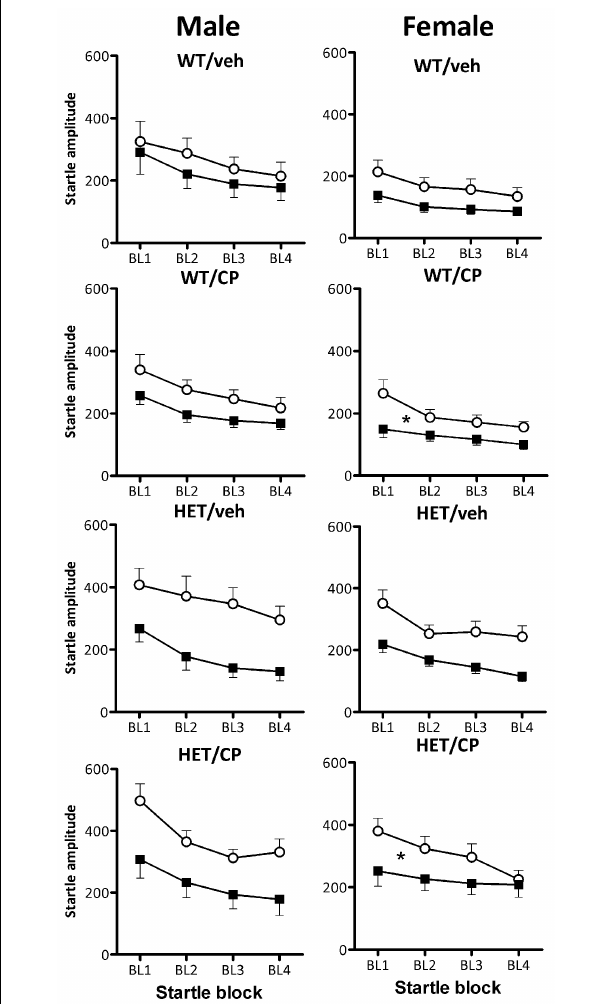
FIGURE 7 | Startle habituation expressed per startle block in the four treatment groups: WT/veh, WT/CP, HET/veh, and HET/CP in both sexes. All groups were acutely administered saline (Sal; open circles) and 0.4mg/kg CP55,940 (CP; black squares). Data are mean ± SEM. ∗ P < 0 . 05 for acute CP injection to reduce startle habituation in female WT and HET mice previously treated with CP in young-adulthood based on ANOVA interaction. Even though acute CP injection reduced startle overall (see Figure 6 ), it had no effect on startle habituation in any of the other groups. For statistical analysis, see text.